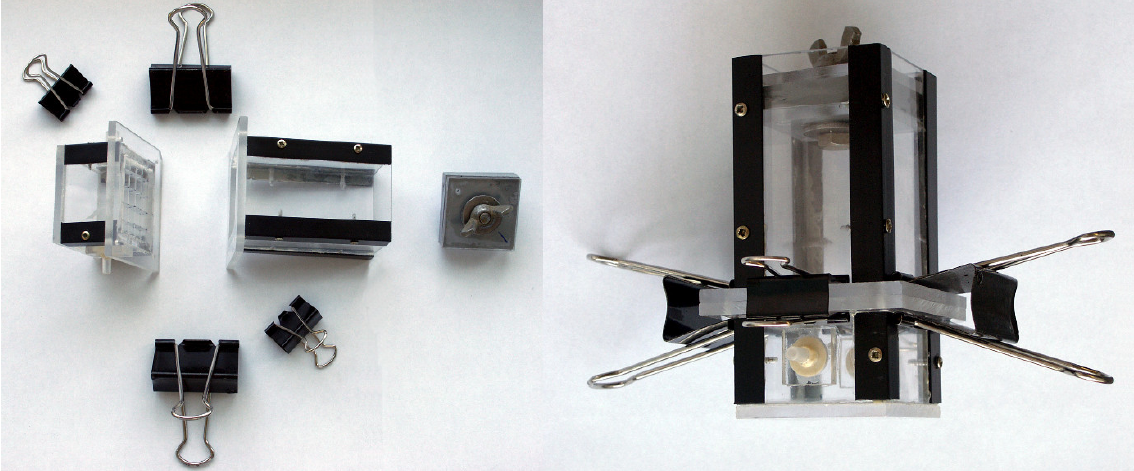
Figure 1. The chamber for CO experiments before and after